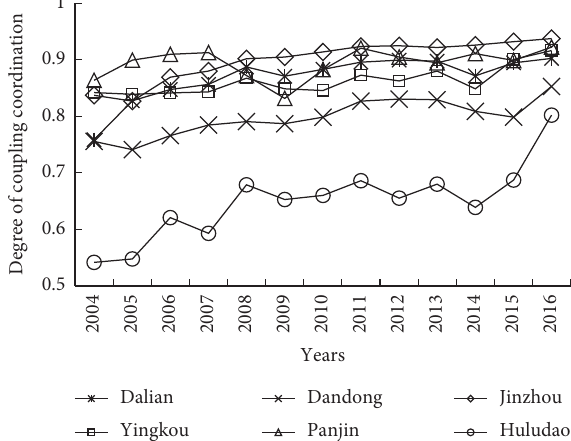
Figure 5: Evaluation of the degree of coordination between in- tensive sea use and marine economy.